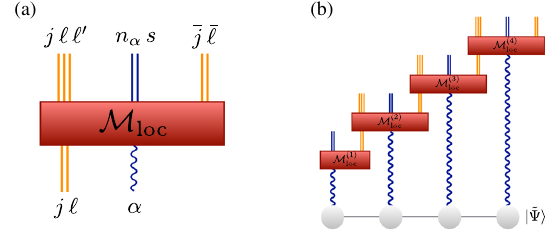
that locally maps loc ¯ l ¯ j ¼ j þ q α and ¼ l 0 þ s